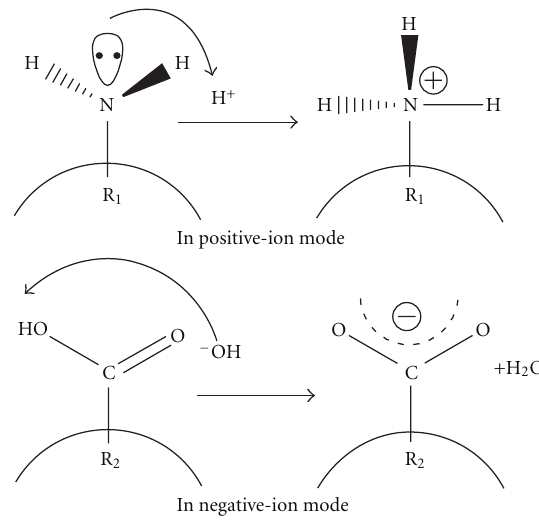
Figure 10: The proton transfer reaction responsible for protein charging in gas phase via